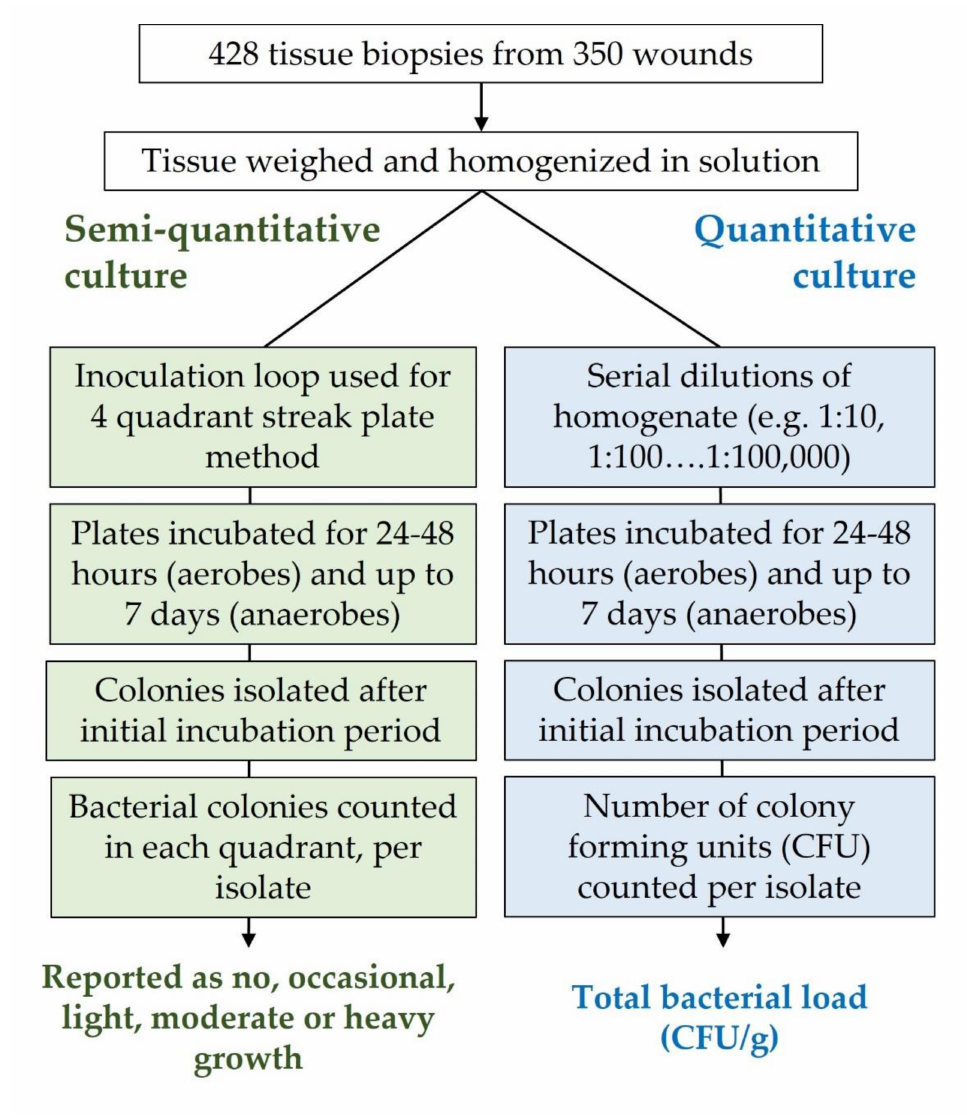
Figure 1. Semi-quantitative and quantitative culture methodology. In total, 428 biopsies were col- lected from 350 wounds; each biopsy was split in half for semi-quantitative and quantitative analysis. For quantitative analysis (Figure 1), the homogenate solution was serially diluted in saline solution (1:10 to 1:10,000), transferred onto agar plates, and incubated overnight and then monitored every 24 h for up to 7 days. After incubation, colonies were counted and recorded from each plate that had grown between 0–100 colonies. Colony forming units per gram (CFU/g) were calculated by multiplying the recorded value by the dilution factor then multiplying by the correction factor for the weight of the biopsy and the partial volume of homogenate solution that was plated. Distribution of the CFU/g bacterial loads corresponding to the semi-quantitative categories was statistically analyzed by log transforming the data, performing linear regression, and the Mann–Whitney and Wilcoxon tests; outlier rejection was performed resulting in the removal of 112 out of 1053 data points. To identify bacterial species (Figure 2), matrix assisted laser desorption ionization-time of flight mass spectrometry (MALDI-TOF; Bruker Daltonics, Billerica, MA, USA) was used